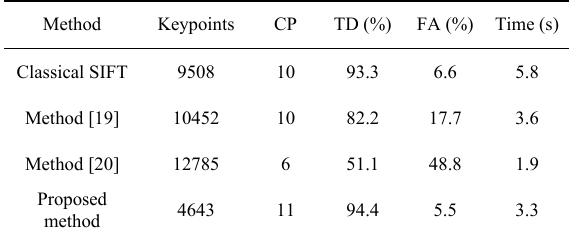
Table 3 Performance comparison of different